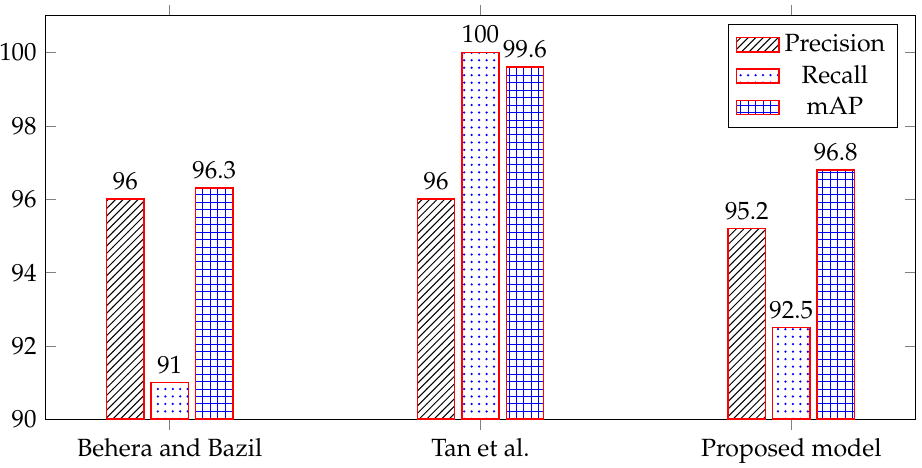
Figure 12. Precision, recall, and mAP results achieved by proposed model for the training set compared to Behera and Bazil [42] and Tan et al.